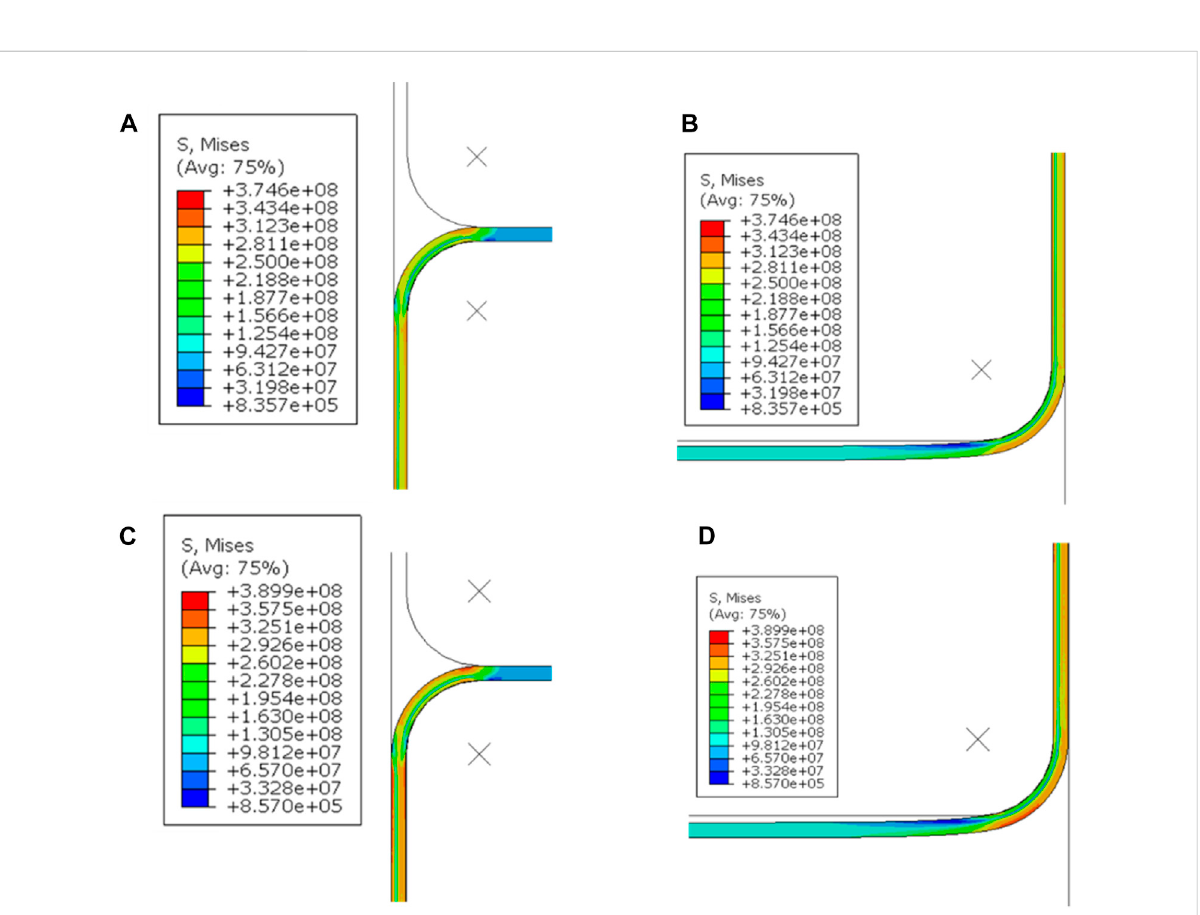
Developedstressesat250 ° Con (A) thetophalfoftheA242strip, (B) thebottomhalfoftheA242strip, (C) thetophalfoftheA242+TiBstrip, (D) the bottom half of the A242 + TiB